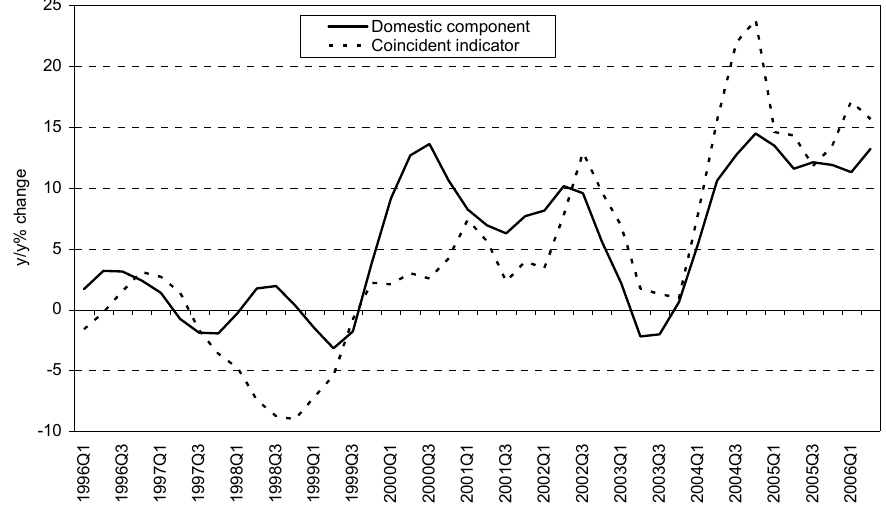
Source: Results from regression model in